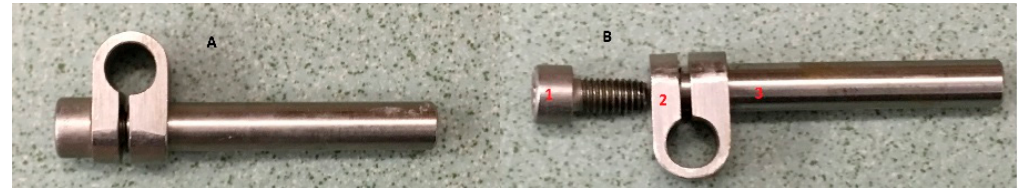
Figure 2. Arm and its elements: ( A ) Mounted arm; ( B ) parts of the arm; ( 1 ). M5 screw, ( 2 ) clamp, ( 3 ) rod.